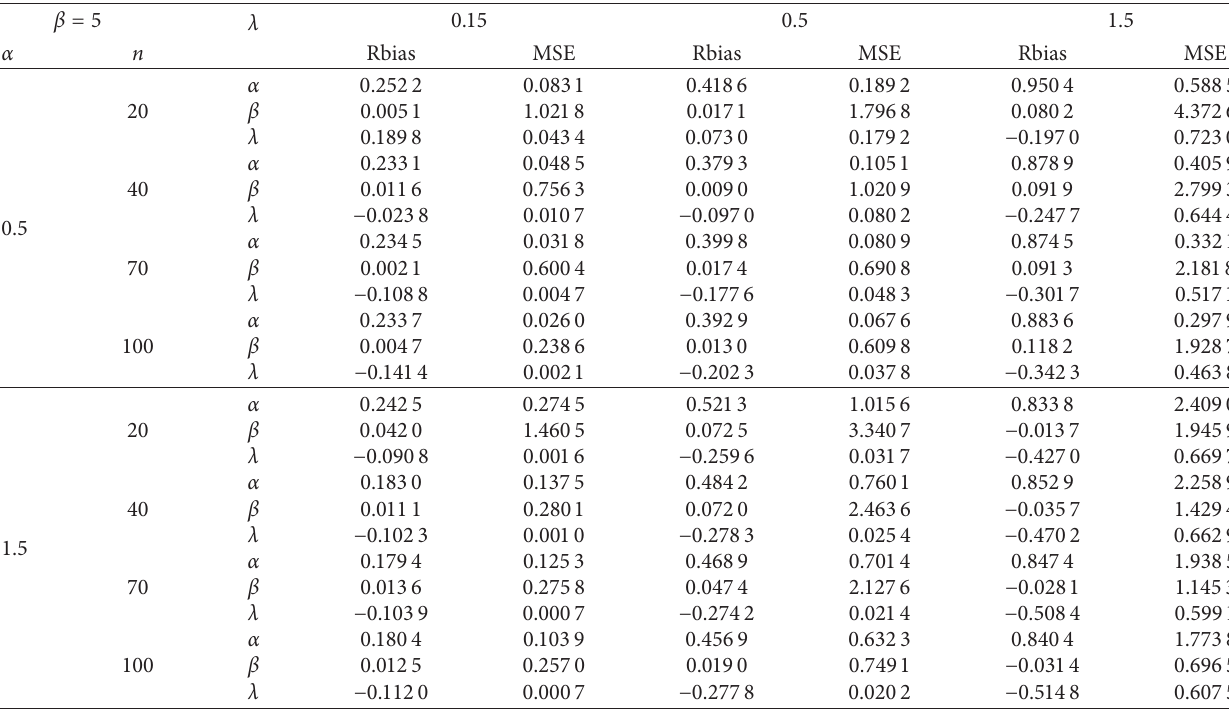
Table 4: Rbias and MSE for parameter of DEOWE distribution by using MLE when β �